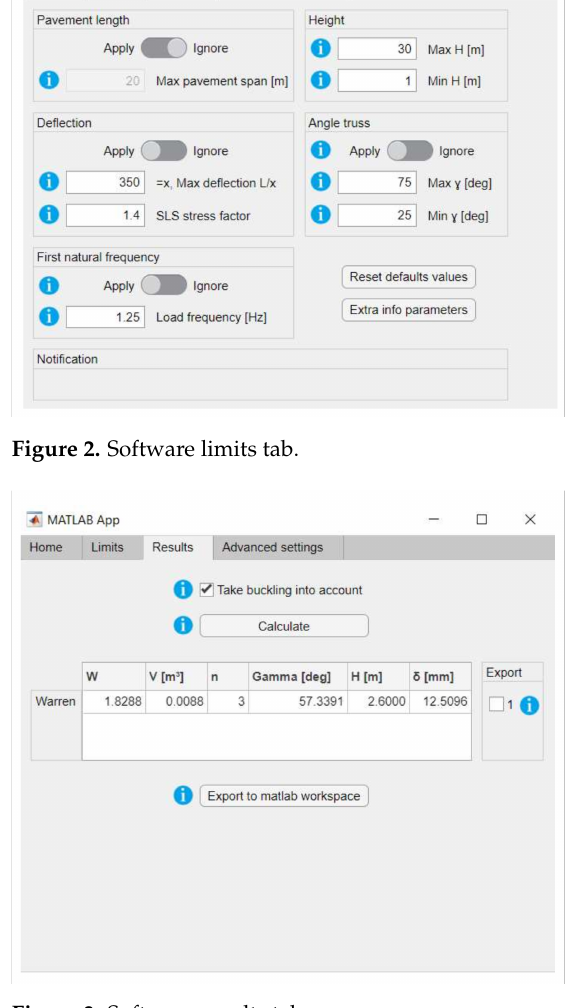
Figure 3. Software results tab.